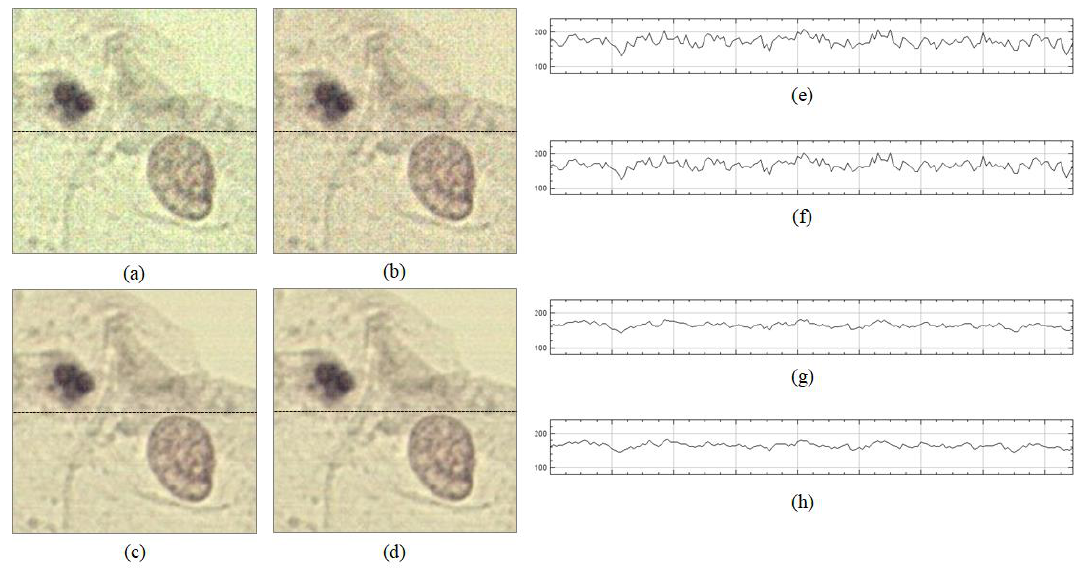
Figure 8. Example of fixed-pattern noise: ( a ) input image tile, ( b ) enlarged image and ( c ) intensity profile for the red channel on dotted line segment of ( b ).